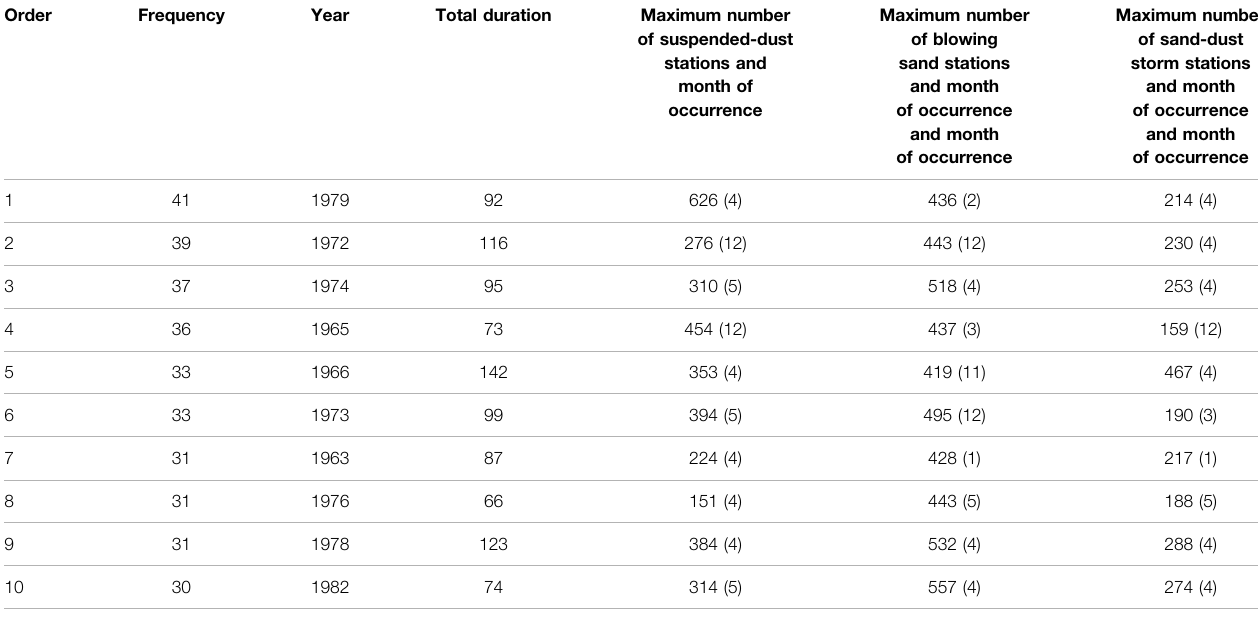
TABLE 2 | The top 10 years with the most sand-dust processes, the months with the most sand-dust processes in the 10 years, and the maximum number of affected stations in a sand-dust process during 1961 – 2020. Order